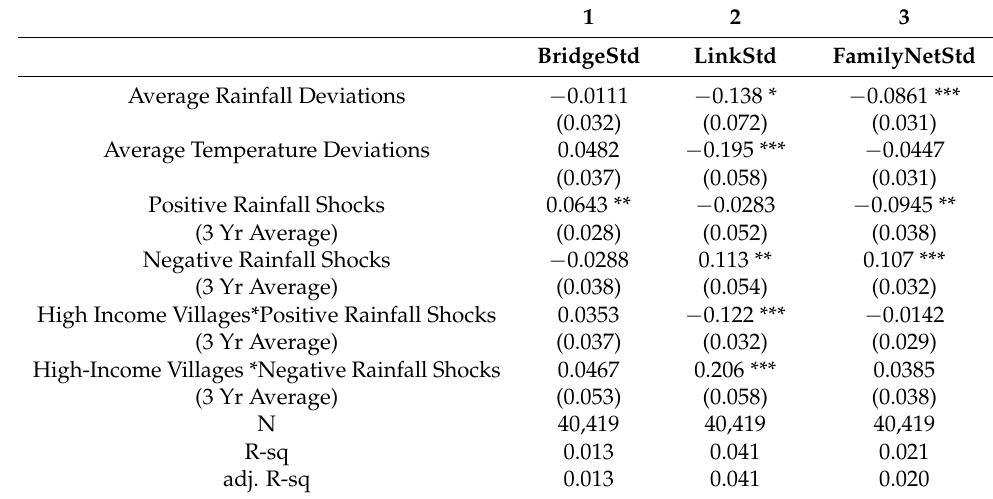
Table A3. Results assessing the impacts of average climate shocks on social networks among high- income